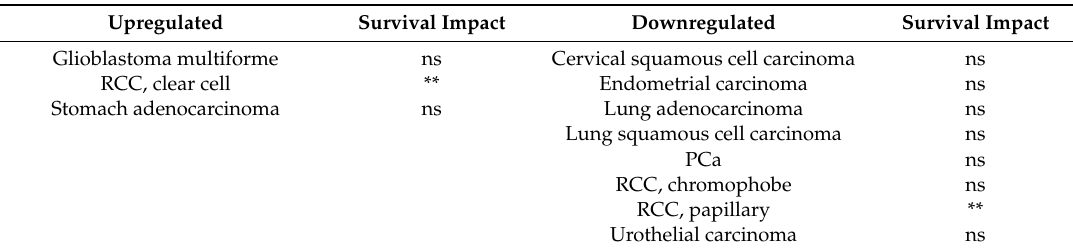
Table 3. Tumor entities with significantly aberrant VEGFR2 / KDR expression in malignant tissue— according to the TCGA (The Cancer Genome Atlas) database, accessed via the UALCAN web resource. Upregulated Survival Impact Downregulated Survival Impact Glioblastoma multiforme ns Cervical squamous cell carcinoma ns RCC, clear cell ** Endometrial carcinoma ns Stomach adenocarcinoma